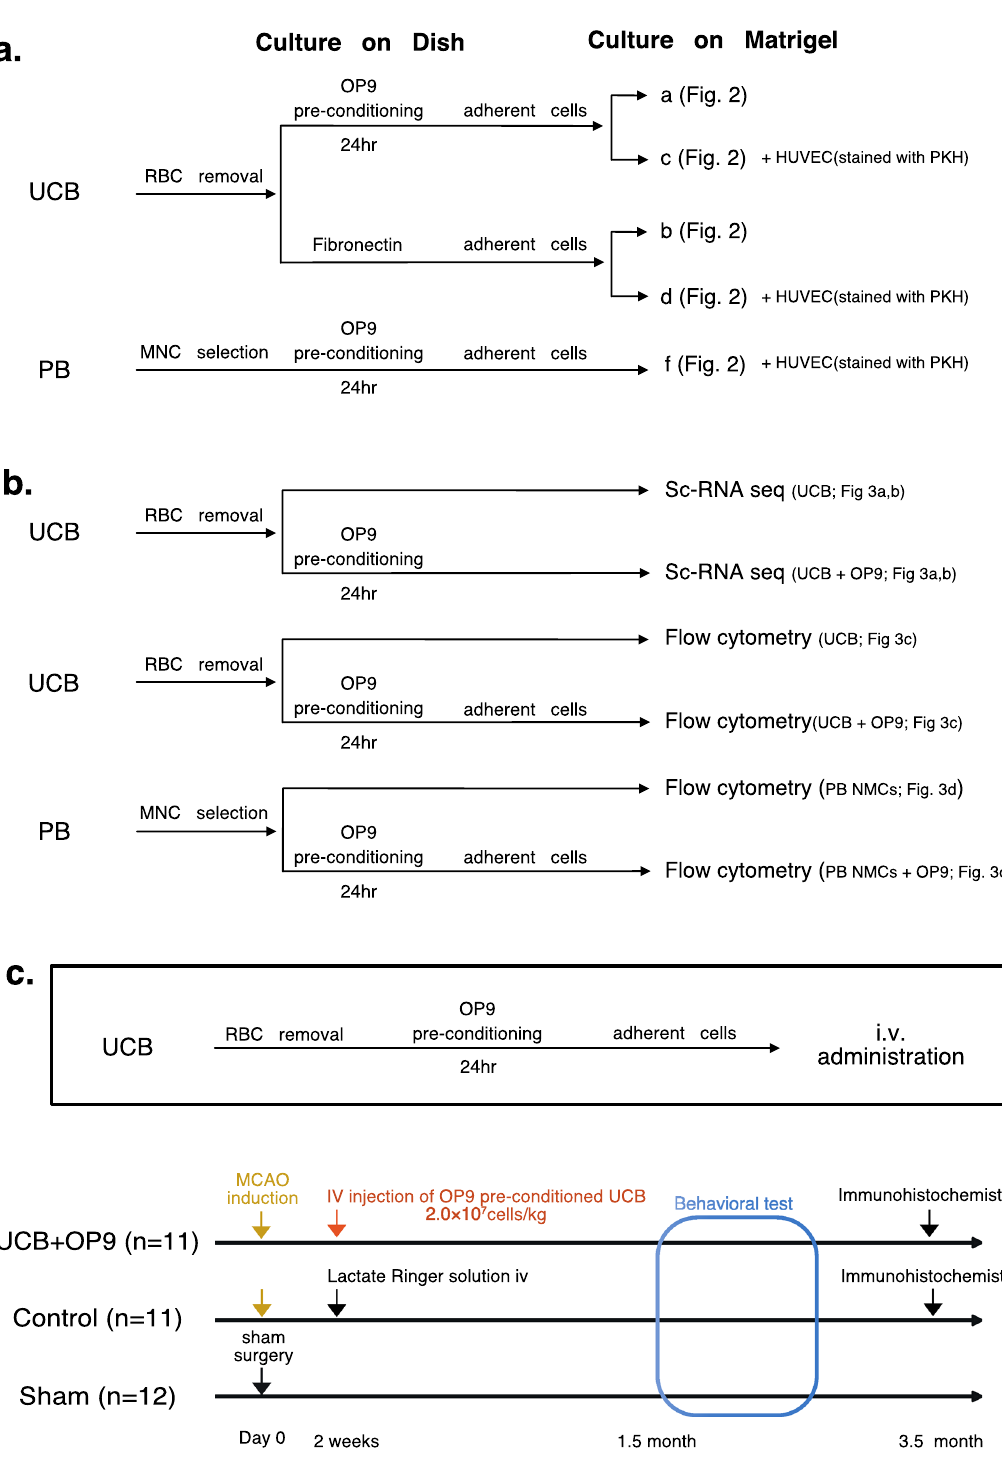
Figure 1. Methodological schematic representations for the study. ( a ) Protocol for the network formation assay. RBC depleted human umbilical cord blood (UCB) cells and peripheral blood-derived mononuclear cells (PB-MNCs) were co-cultured on OP9 stromal cells (i.e. OP9 pre-conditioning) in 10-cm dishes. After 18–24 h culture, adherent cells were harvested and subjected to in vitro network formation assay. RBC depleted crude UCB cells and PB-MNCs cultured on fibronectin-coated dishes were used as control. ( b ) Protocol for the single cell RNA sequencing (scRNA-seq) and flow cytometry. RBC depleted crude UCB cells were used as control. ( c ) Protocol for intravenous administration of OP9 pre-conditioned UCB in the MCAO mouse model. Mice were randomly assigned to three groups as follows: the UCB + OP9 group (n = 11); the control group (n = 11); and the sham surgery group (n = 12) and underwent MCAO or sham surgery. Two weeks after surgery, mice in the UCB + OP9 group received 100 μL of OP9 pre-conditioned UCB (2.0 × 10 7 cells/kg) and mice in the control group received the same amount of lactated Ringer’s solution intravenously (iv.) Next one month after cell transplantation, a series of behavioral tests were performed, and three months after cell transplantation, five mice in the UCB + OP9 group and five mice in the control group were randomly selected and subjected to the